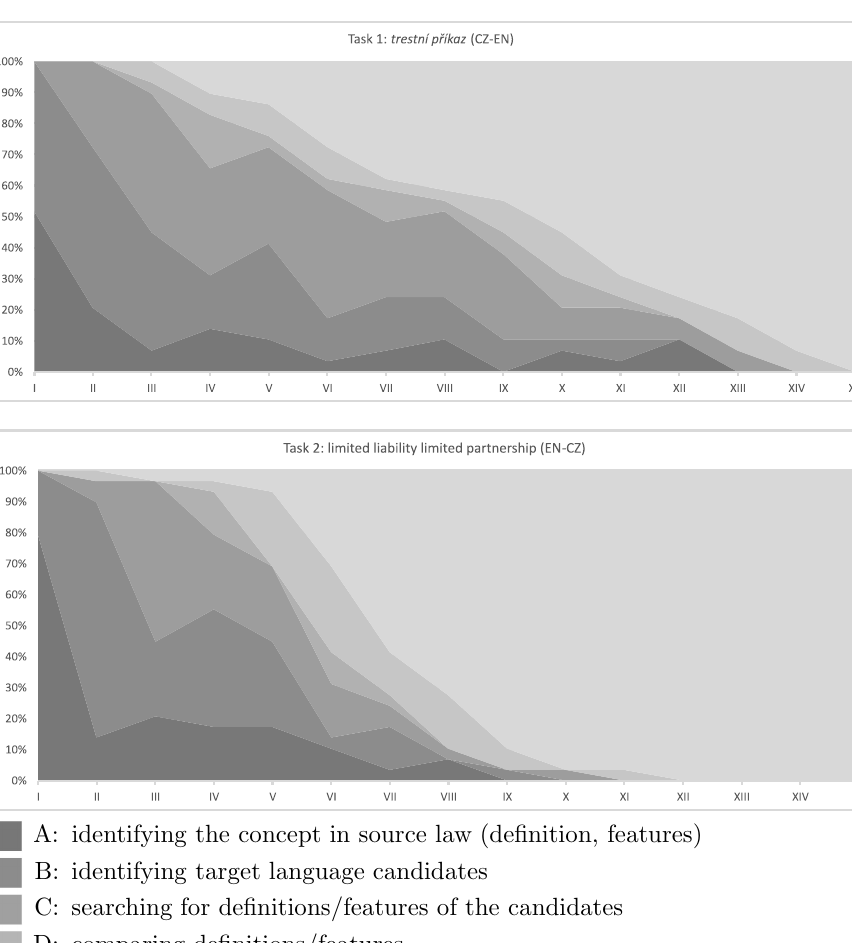
Figure 2. Percentage of subjects performing individual CCA